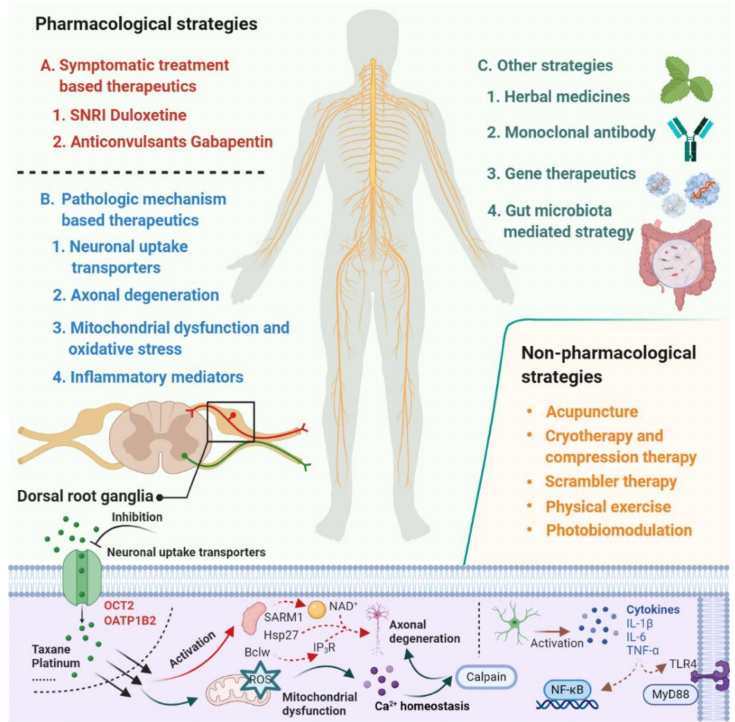
Figure 1. Summary of emerging pharmacological and non-pharmacological therapeutics for preven- tion and treatment of chemotherapy-induced peripheral